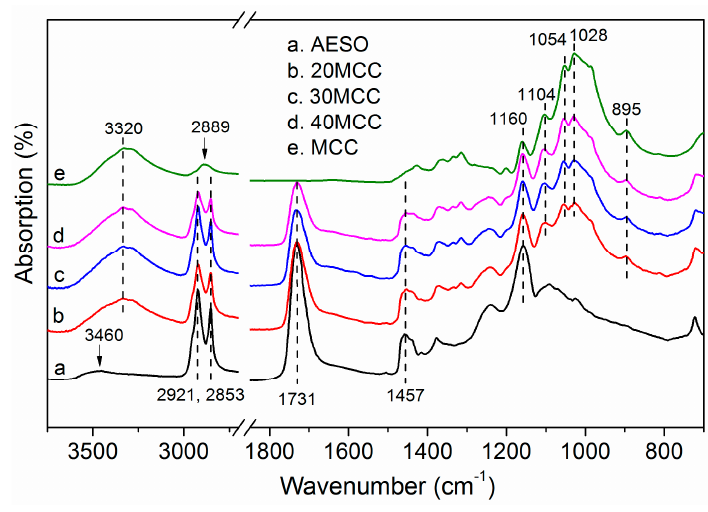
Figure 1. Fourier transform infrared (FTIR) spectra of pure MCC, AESO, and MCC/AESO composites with different MCC loadings.